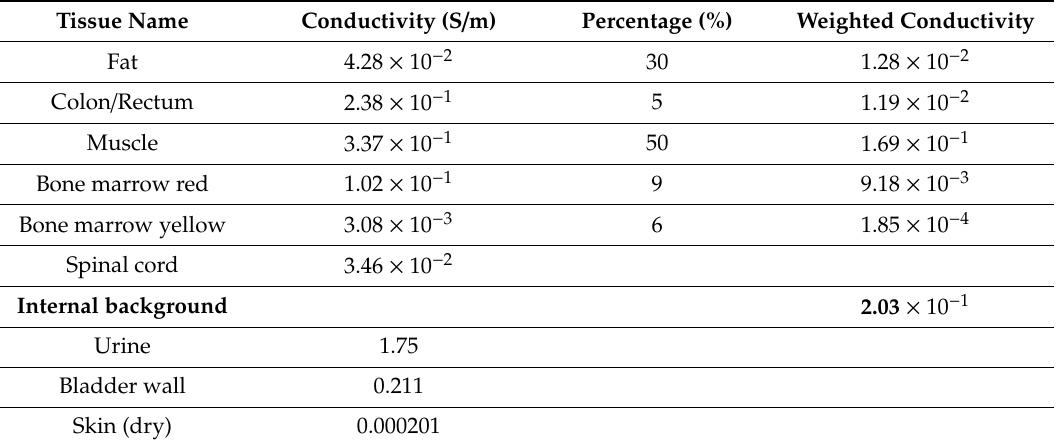
Table 1. Electrical conductivity values of the different tissues to be mimicked.